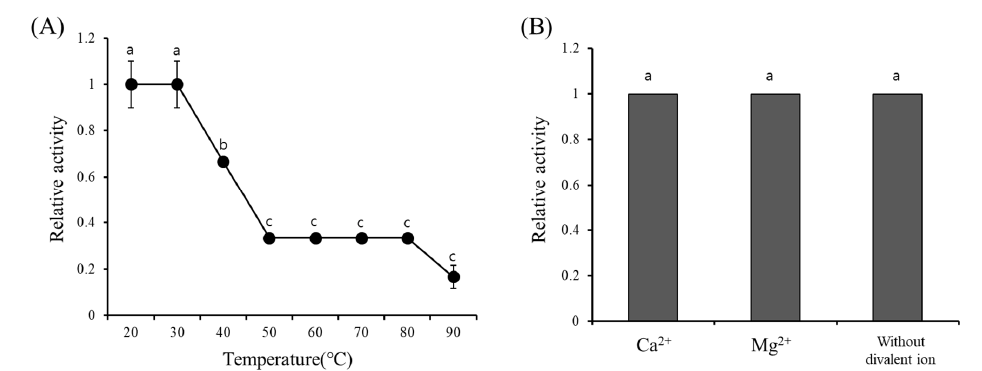
Figure 3. Activity of Grateloupia chianggi lectin (GCL) at various temperatures and in the presence of divalent ions. ( A ) Effect of temperatures on GCL activity. ( B ) Effect of the presence or absence of divalent ions, n = 3. Error bars represent mean ± standard deviation of triplicate experiments and different letters indicate significant difference ( p < 0.05).